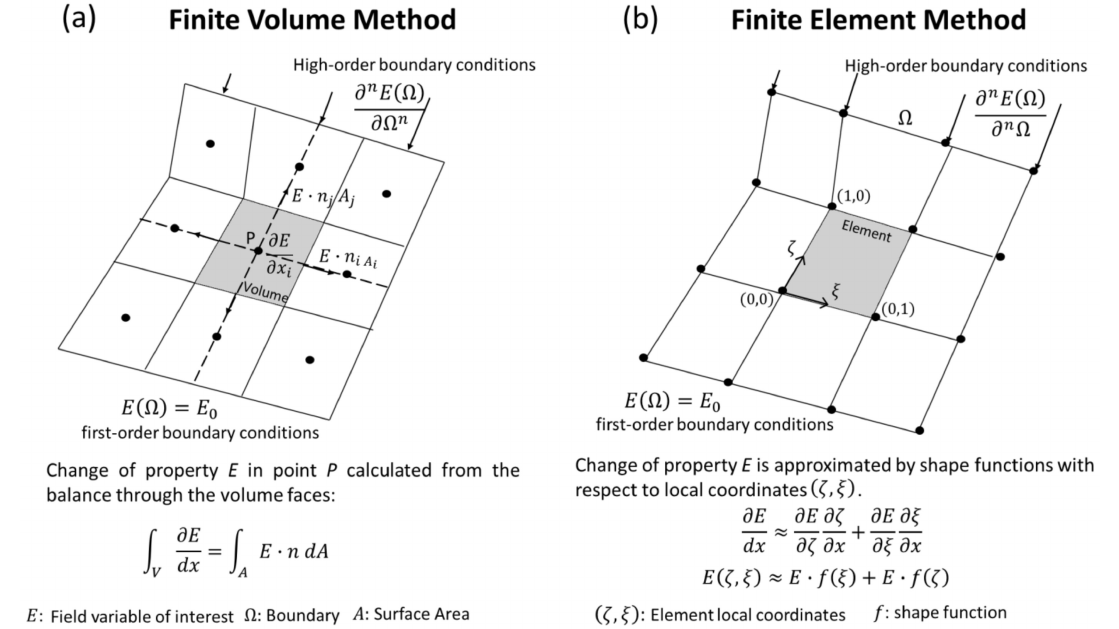
Figure 4. Diagram of finite volume (FVM) and finite element methods (FEM) approximation princi- ples. ( a ) In FVM, the domain is discretized in finite volumes, and balance equations are solved at the center of each volume. ( b ) In FEM, the domain is discretized in finite elements, and the variables distribution is assumed to follow a prescribed shape function within each finite